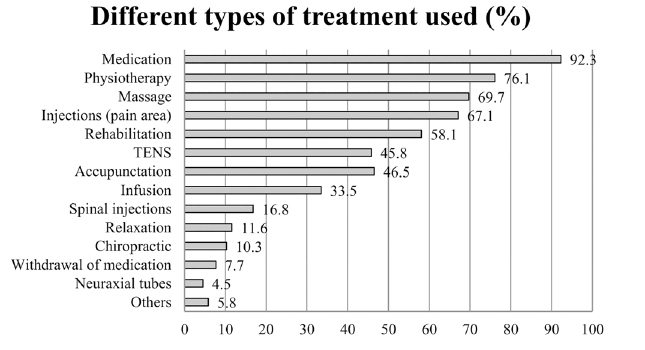
Fig 3. Different types of treatments used in percent (%).